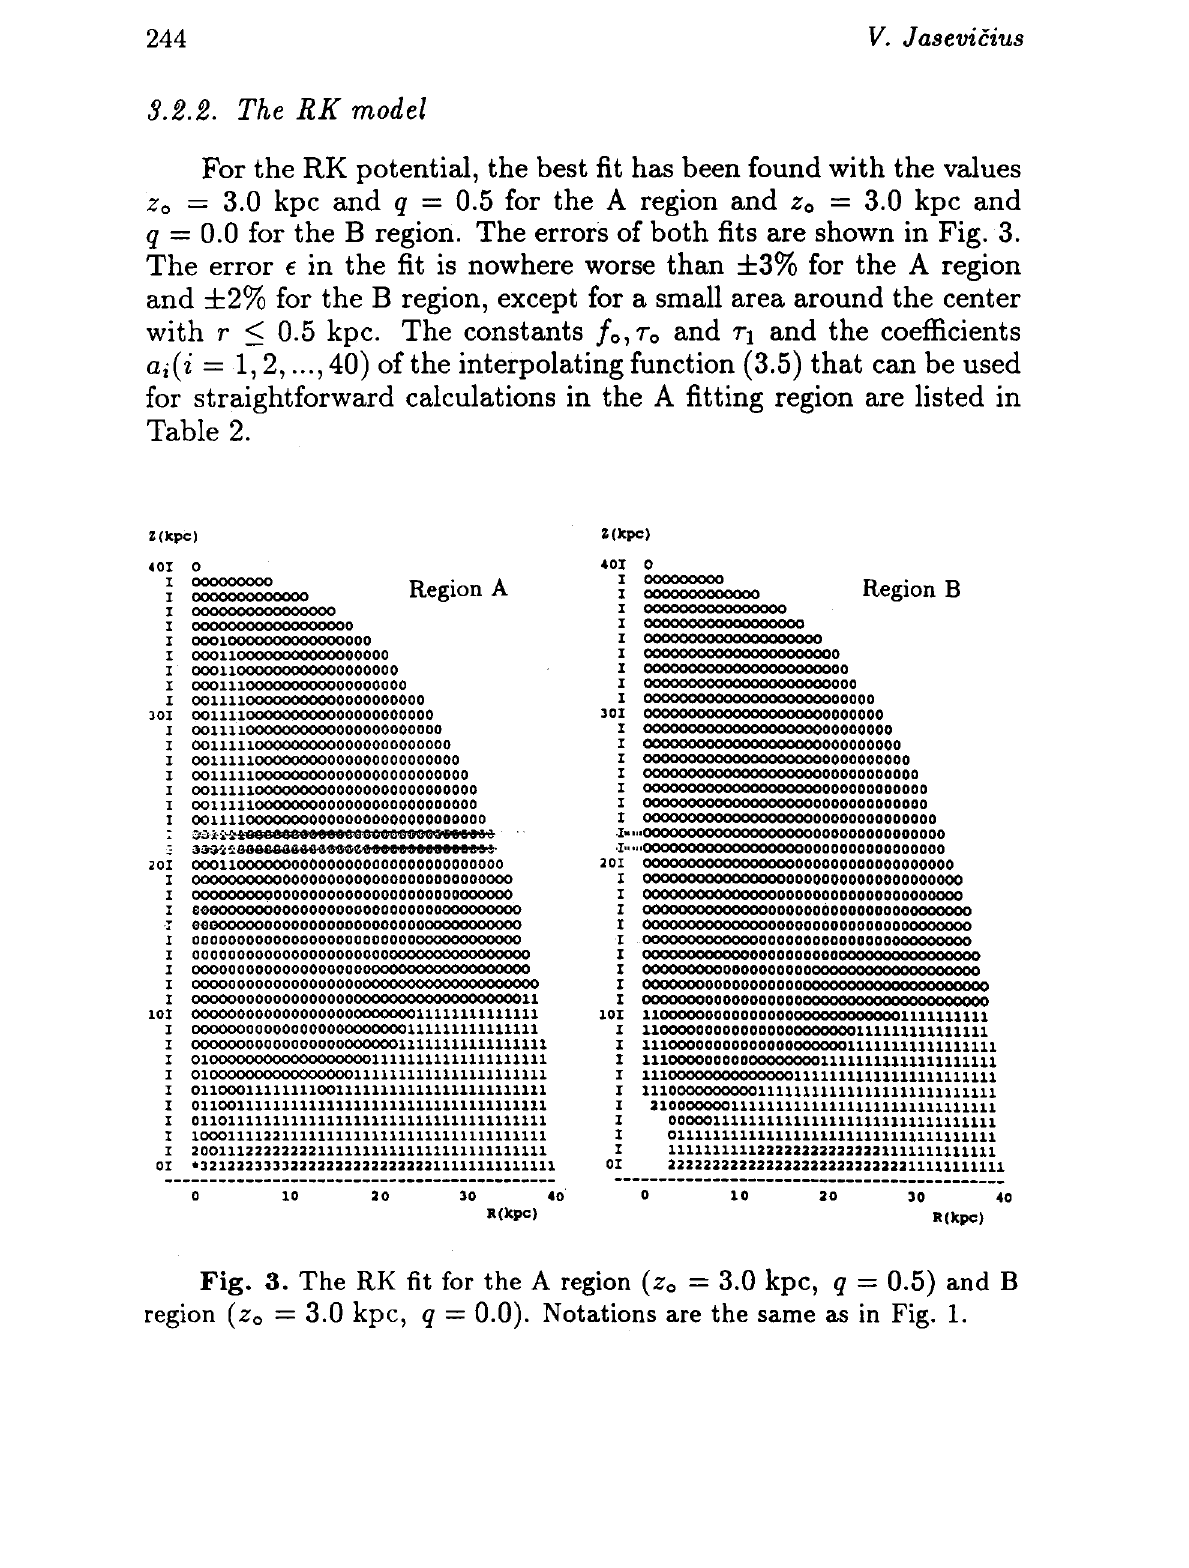
Fig. 3. The RK fit for the A region (z a = 3.0 kpc, q - 0.5) and B region (z 0 = 3.0 kpc, q = 0.0). Notations are the same as in Fig.